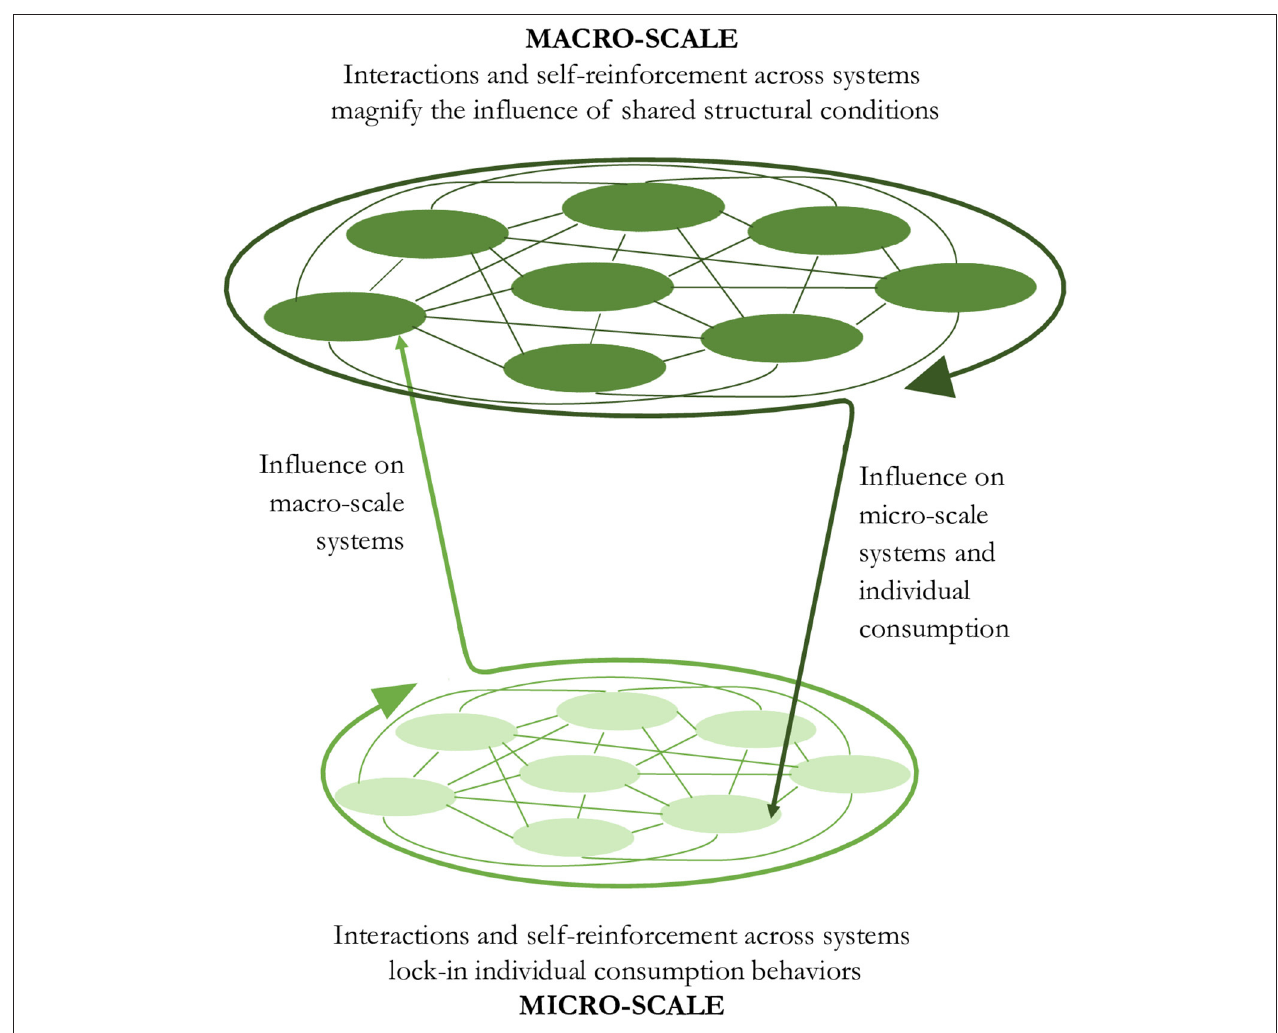
FIGURE 1 | Mechanisms contributing to the lock-in of urban consumption (Source: